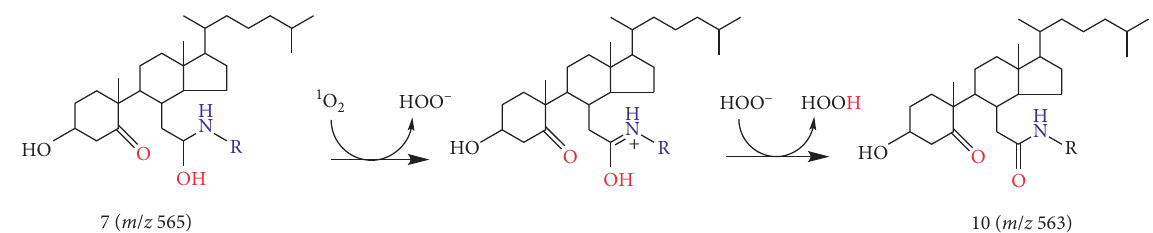
Scheme 5: Proposed singlet oxygen-mediated conversion of carbinolamine 7 to amide-type adduct 10